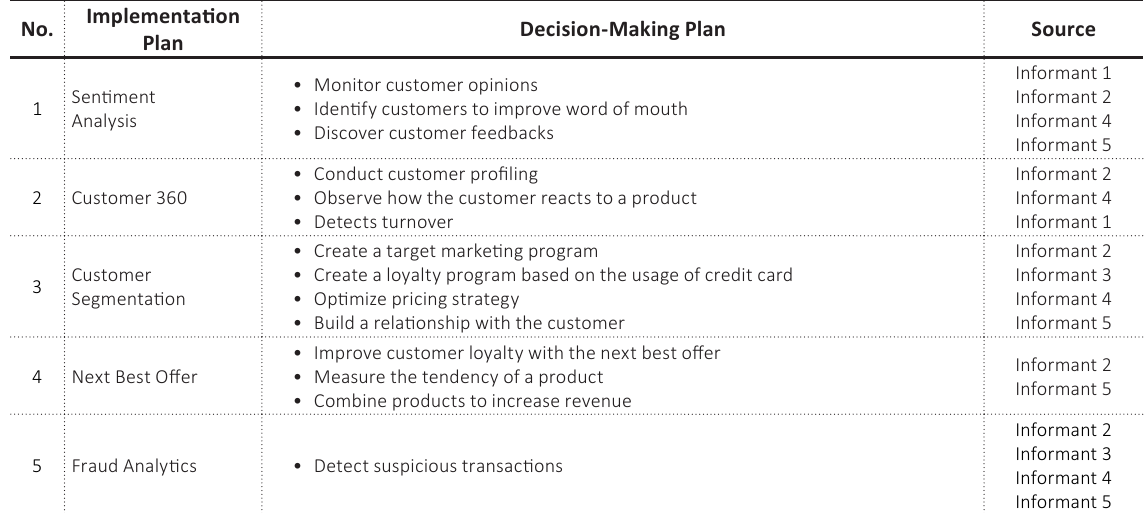
Table 3. Summary of big data implementation